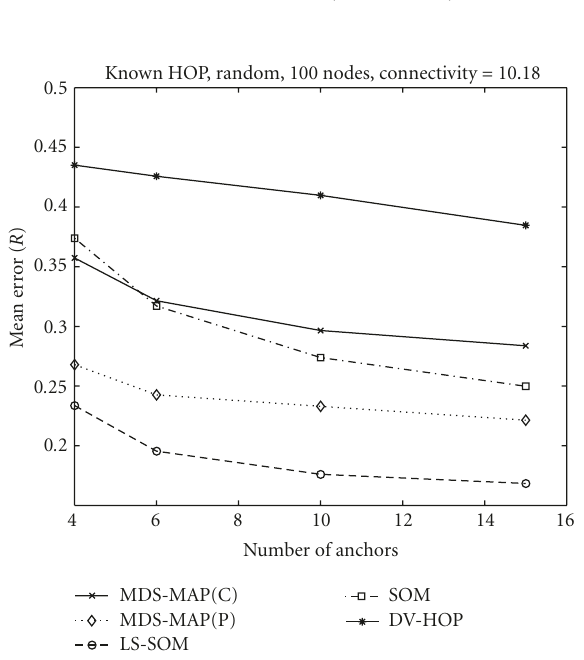
Figure 6: Performace by anchors.